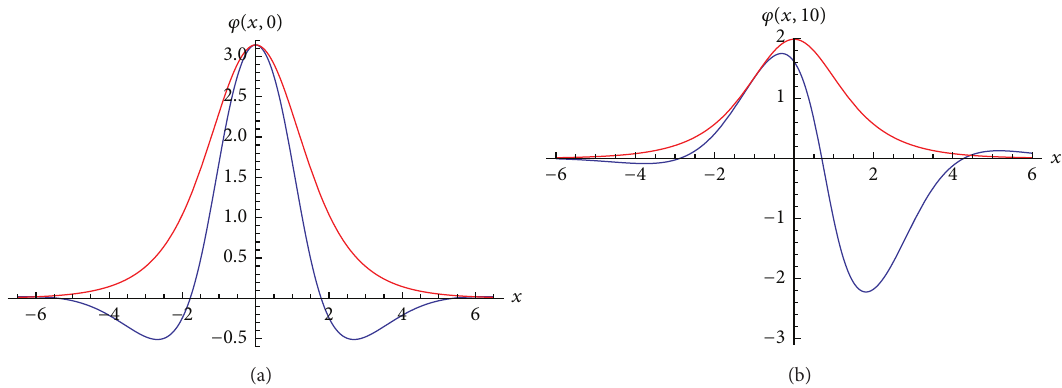
Figure 4: Profile of the breathers 1 + 1 -dimensions with Lorentz symmetry breaking for 𝑡 = 0 (left) and 𝑡 = 10 (right) with V = 2 , 𝑤 = 1 , and 𝛽 = 1 . The thin line corresponds to the case with 𝑘